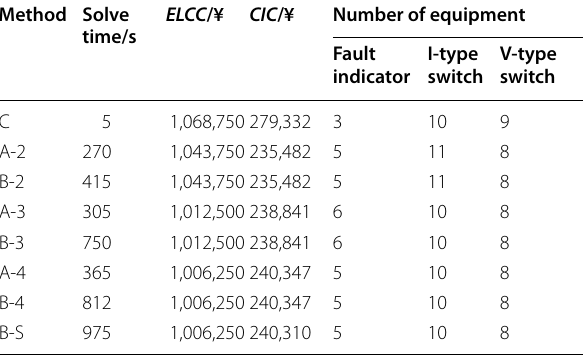
Table 11 Solution results when the failure probability of single equipment is